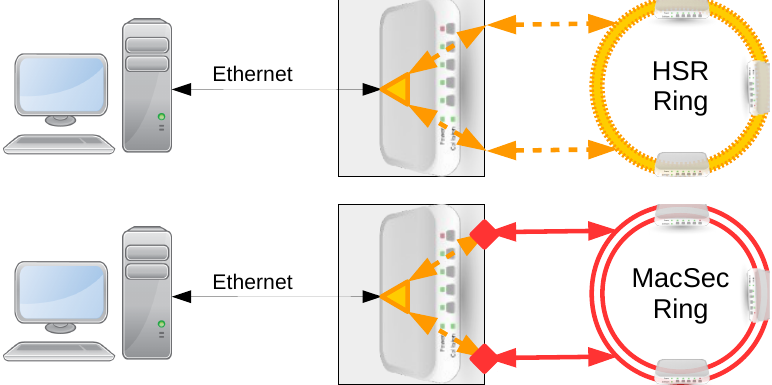
Figure 8. Standard DAN (top) and HSR in MACsec enabled DAN (bottom). Short dashed lines indicate standard HSR traffic. The MACsec header is included as the last element so the traffic in the ring is MACsec compliant.